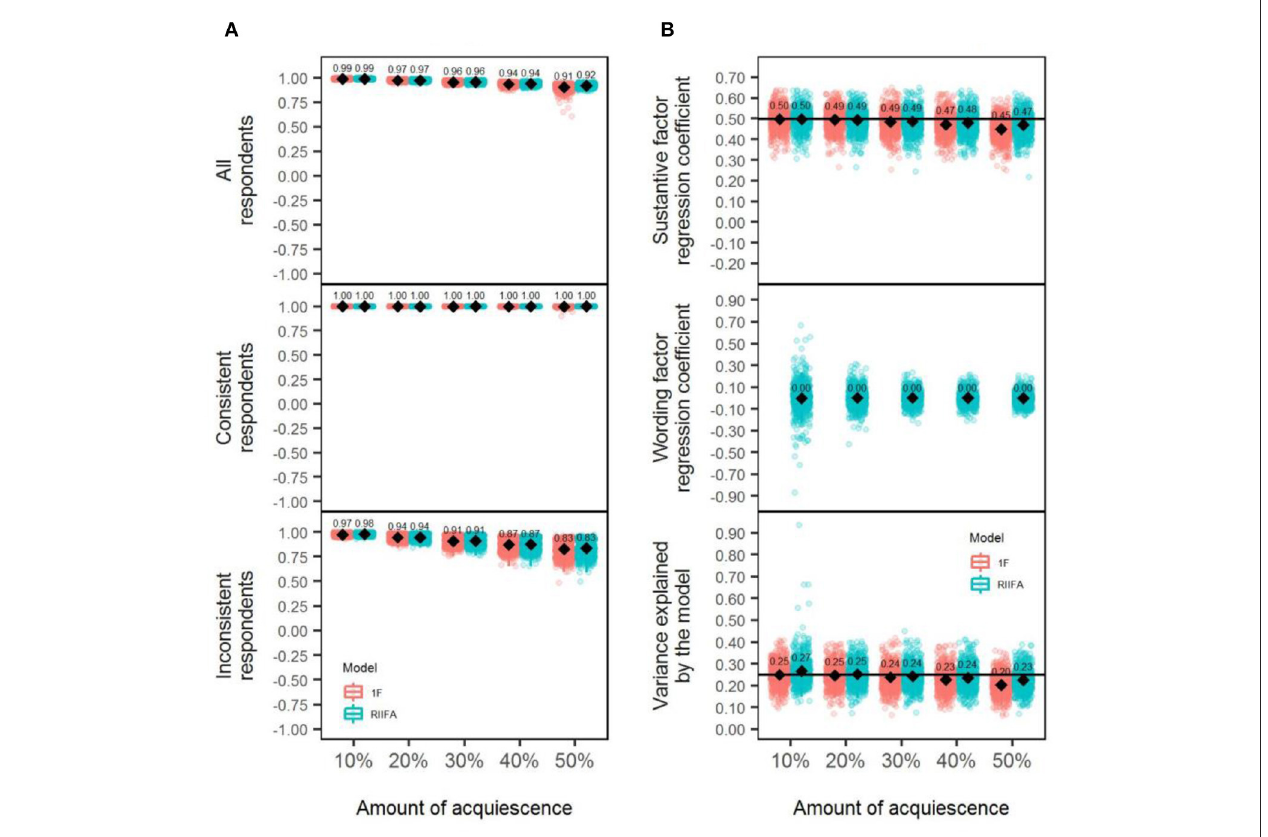
FIGURE 9 | Recovery of substantive factor scores and estimation of structural validity with the 1F model and the RIIFA model in the presence of acquiescence. In (A) , represented values are Pearson correlations, and results of the recovery of uncontaminated scores are presented for all the respondents, separately for consistent respondents, and separately for inconsistent respondents. 1F, unidimensional model with one substantive factor; RIIFA, random intercept item factor analysis model with one substantive factor and one wording method factor. In (B) , the horizontal black lines represent the substantive factor regression coefficient and the variance explained by the model with 0% of wording